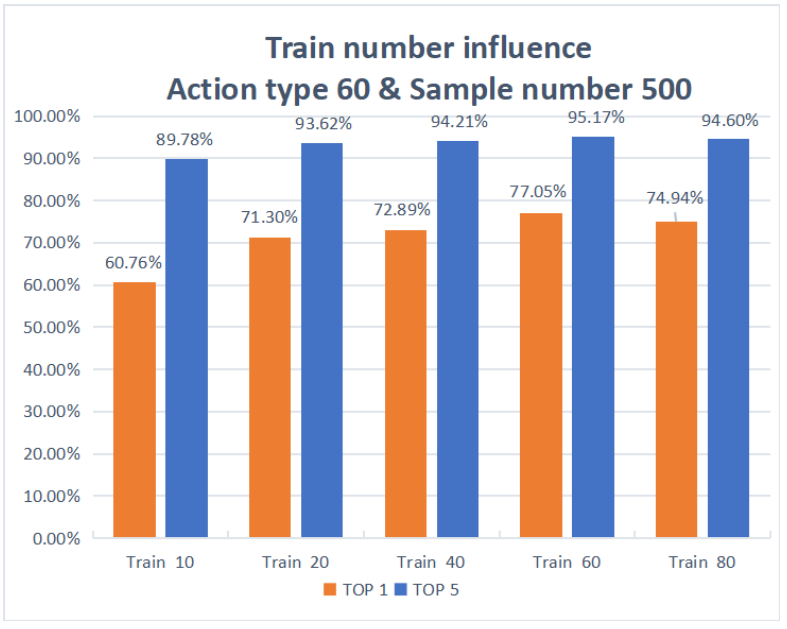
Figure 9. Histogram of the impact of the train